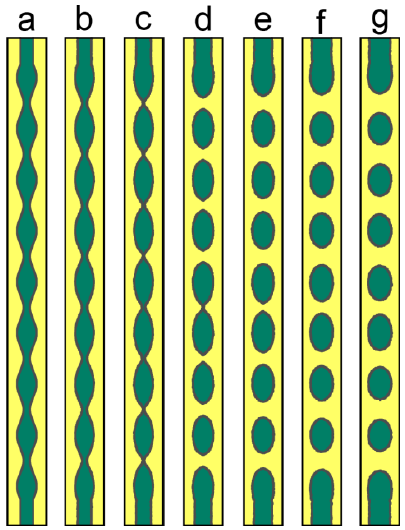
Figure 8. Microstructure evolution of a long cylinder with sinusoidal perturbation on the surface. ( a ) t = 0 s; ( b ) t = 0.4 s; ( c ) t = 0.7 s; ( d ) t = 1 s; ( e ) t = 1.2 s; ( f ) t = 1.4 s; ( g ) t = 1.6 s. Simulation grid is 3000 × 240 with the cell size of 0.001 μm.